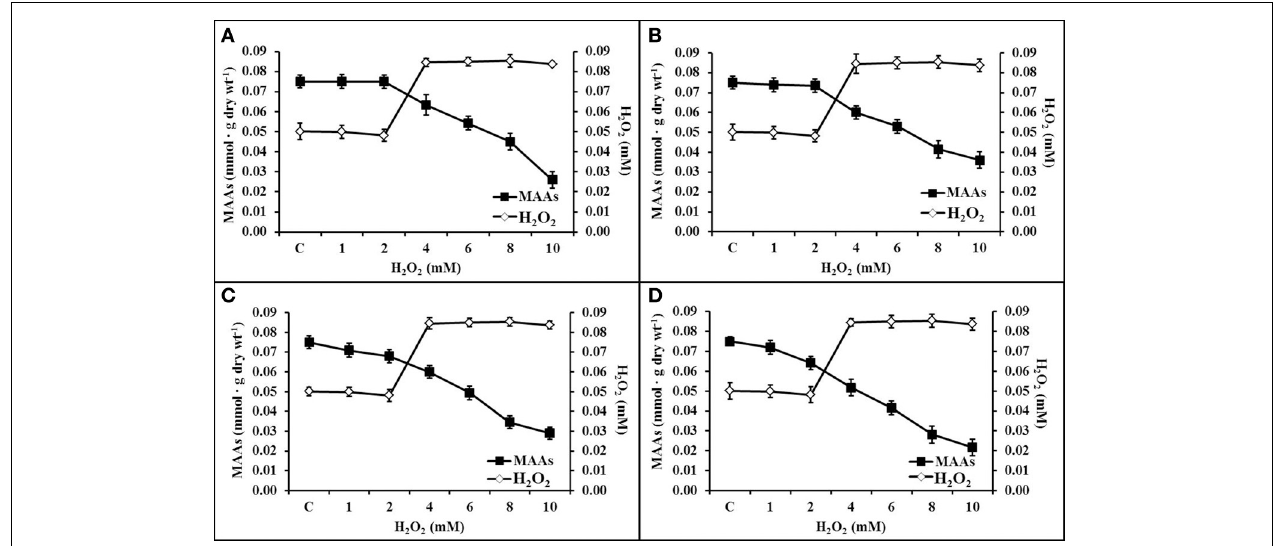
FIGURE 7 | Diagonal relationship of scavenging potential of MAAs in different concentrations of H 2 O 2 (0–10mM). Inactivation of H 2 O 2 by MAAs at 323nm (A) , 328nm (B) , 335nm (C) , and 340nm (D)